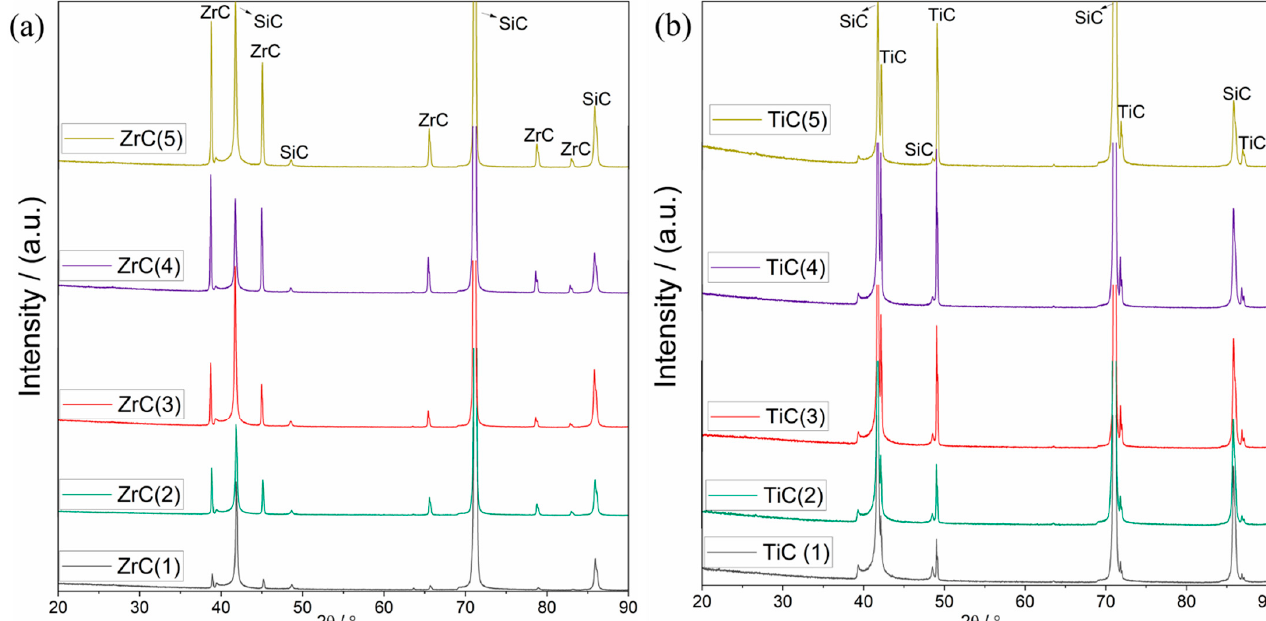
Figure 7. XRD patterns of carbides by dipping method before joining. ( a ) ZrC; ( b ) TiC.